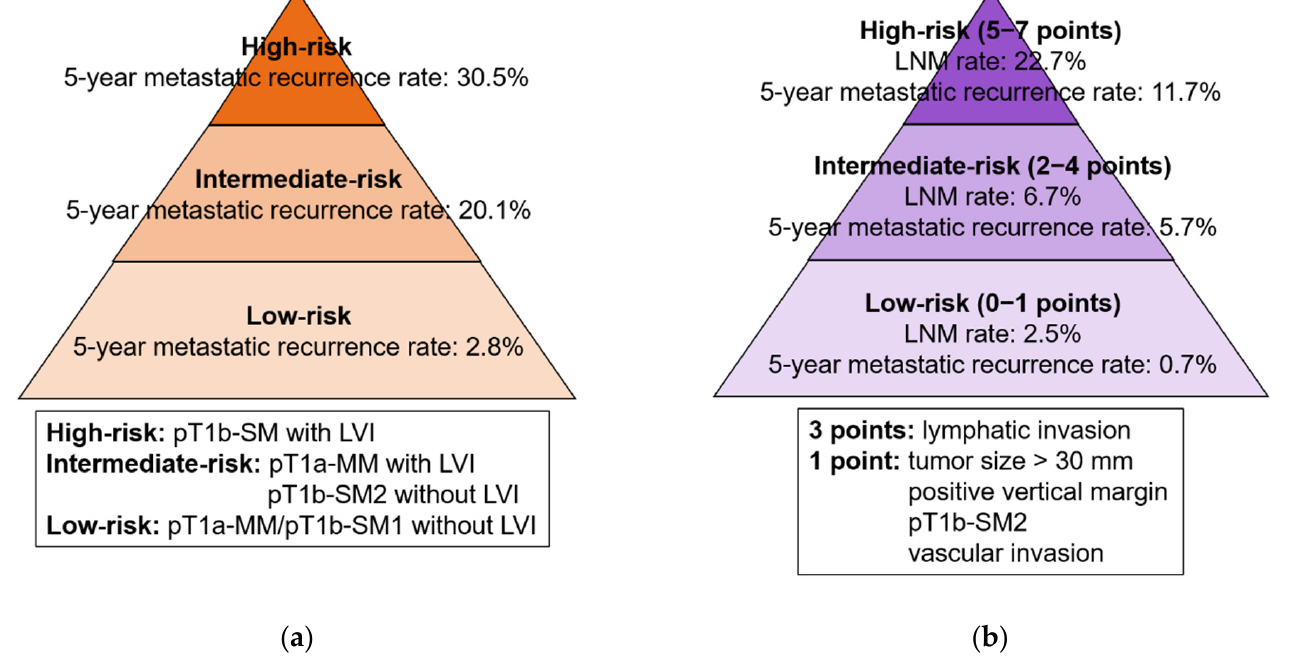
Figure 2. ( a ) Risk classification for LNM and/or metastatic recurrence in patients with non-curative ER for SESCC; ( b ) or EGC. EGC, early gastric cancer; ER, endoscopic resection; LNM, lymph node metastasis; LVI, lymphovascular invasion; pT1a-MM, tumor invasion confined to the muscularis mucosa; pT1b-SM, tumor invasion into the submucosa; pT1b-SM1 (SESCC), tumor invasion con- fined to submucosa ≤ 200 µm; pT1b-SM2 (EGC), submucosal adenocarcinoma invading ≥ 500 µm of the submucosa; pT1b-SM2 (SESCC), tumor invasion into the submucosa > 200 µm; SESCC, superfi- cial esophageal squamous cell carcinoma.